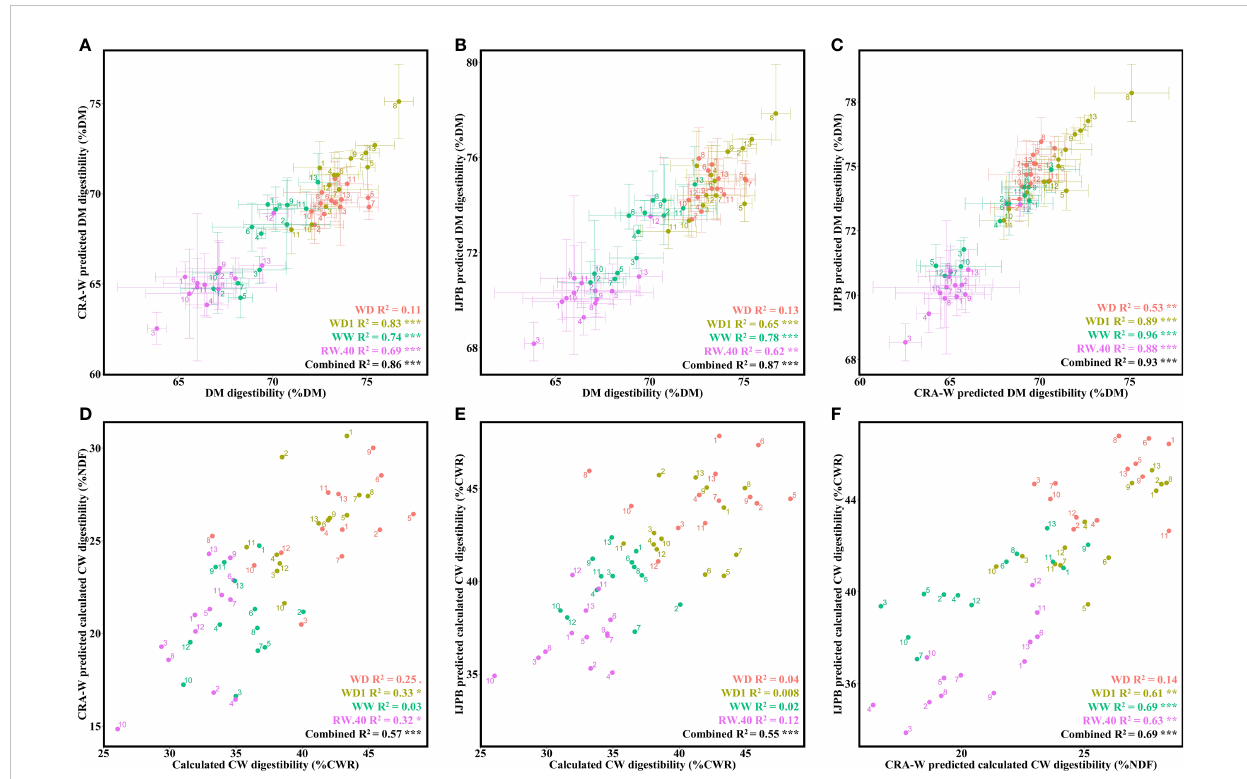
FIGURE 3 Prediction accuracy of CRA-W and IJPB NIRS predictive equations for both DM and CW digestibilities under different hydric conditions. (A) Relationship between DM digestibility predicted by CRA-W and DM digestibility measured in the laboratory. (B) Relationship between IJPB- predicted and laboratory-measured DM digestibility. (C) Relationship between the two predicted means from the IJPB and CRA-W equations for DM digestibility. (D) Relationship between laboratory-calculated CW digestibility and CRA-W-predicted CW digestibility. (E) Relationship between laboratory calculated mean CW digestibility and IJPB-predicted calculated CW digestibility. (F) Relationship between IJPB-predicted calculated CW digestibility and CRA-W-predicted CW digestibility. The dots denote the ratio values for the individuals, unless they are given as mean values, in which case they represent the mean values of the 3 blocks. Linear equation values are proceeded by Pearson correlation signi fi cance symbols: P <0.1:.; P <0.05: *; P <0.01: **; P <0.001: ***. The error bars represent the standard error